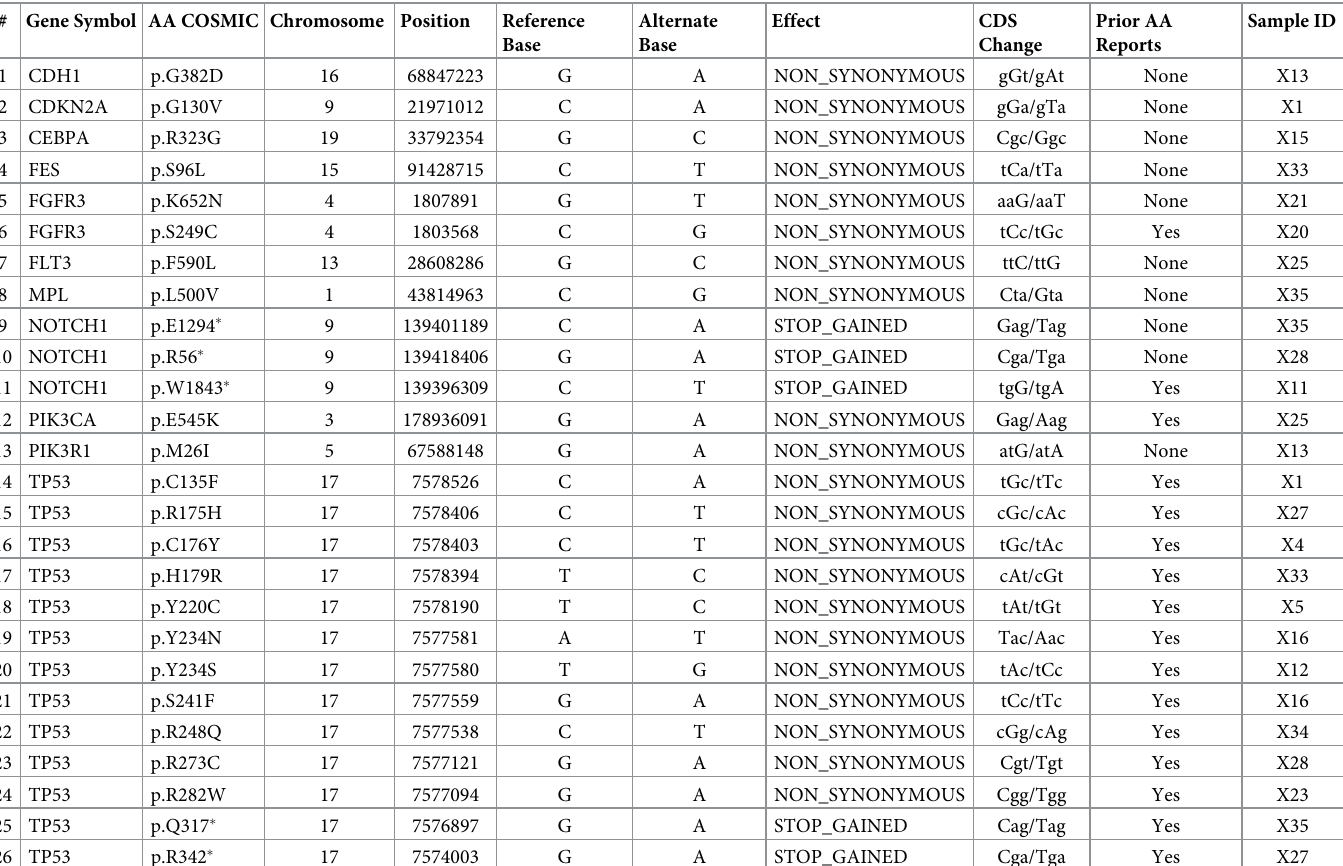
Table 3. Complete list of point mutations among the genes sequenced in the 37 HNSCC